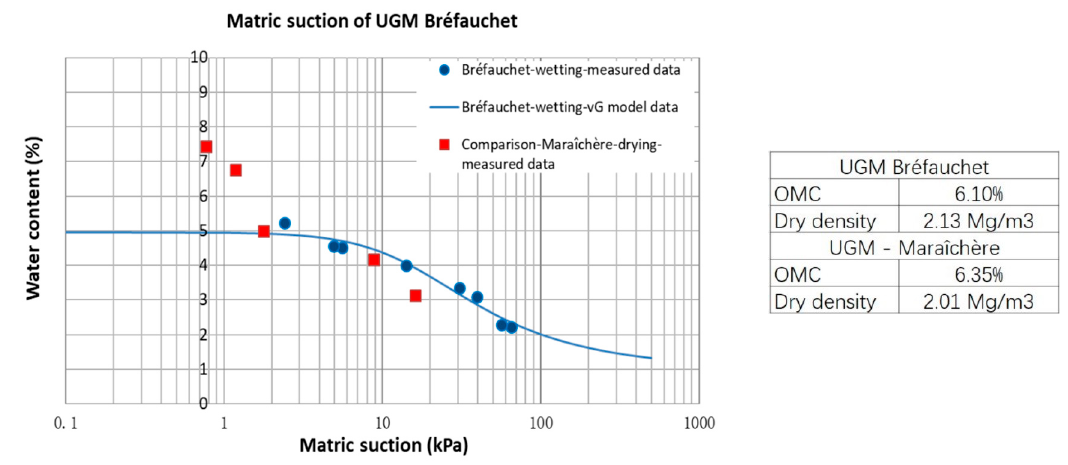
Figure 5. Matric suction of UGM Bréfauchet.